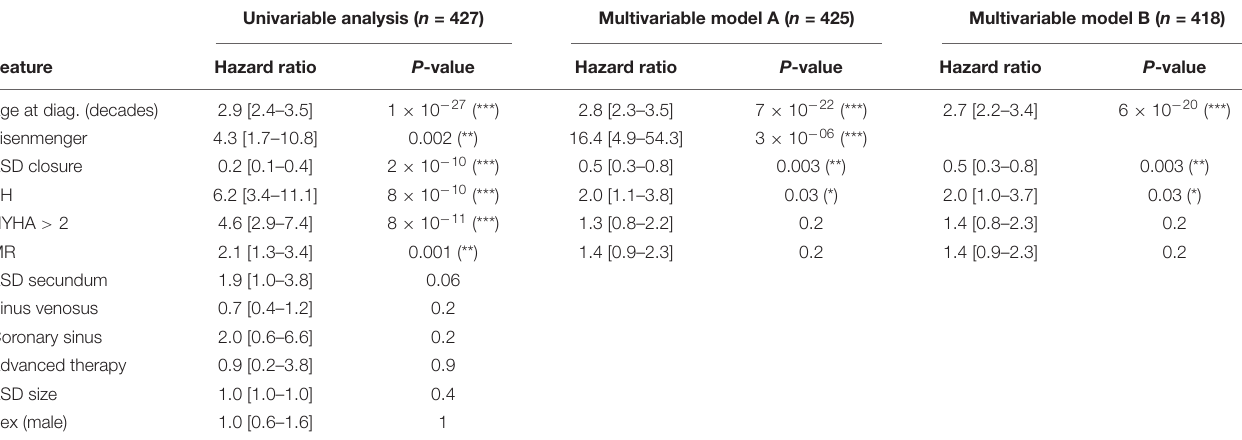
TABLE 2 | Cox-proportional hazards models for mortality prediction. Univariable analysis ( n = 427) Multivariable model A ( n = 425) Multivariable model B ( n = 418)